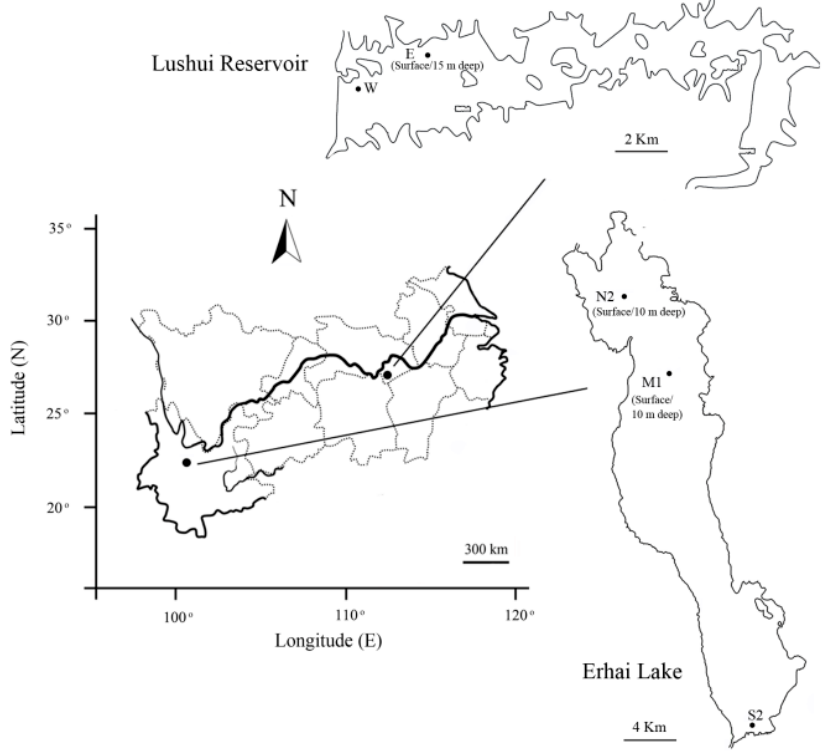
Figure 1. Map of Erhai Lake and Lushui Reservoir showing sampling locations in this study.